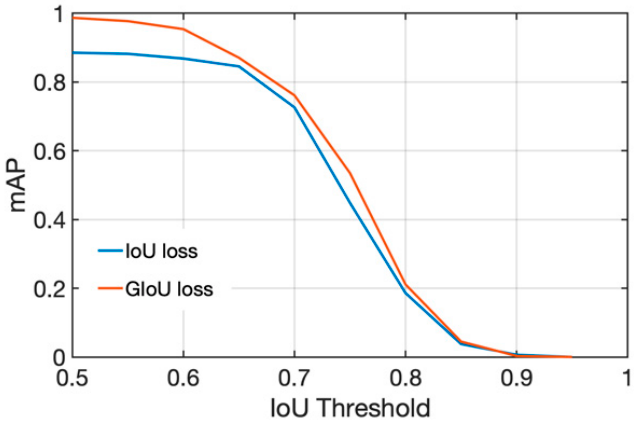
Figure 7. mAP values against different IoU thresholds for IoU loss and GIoU loss.